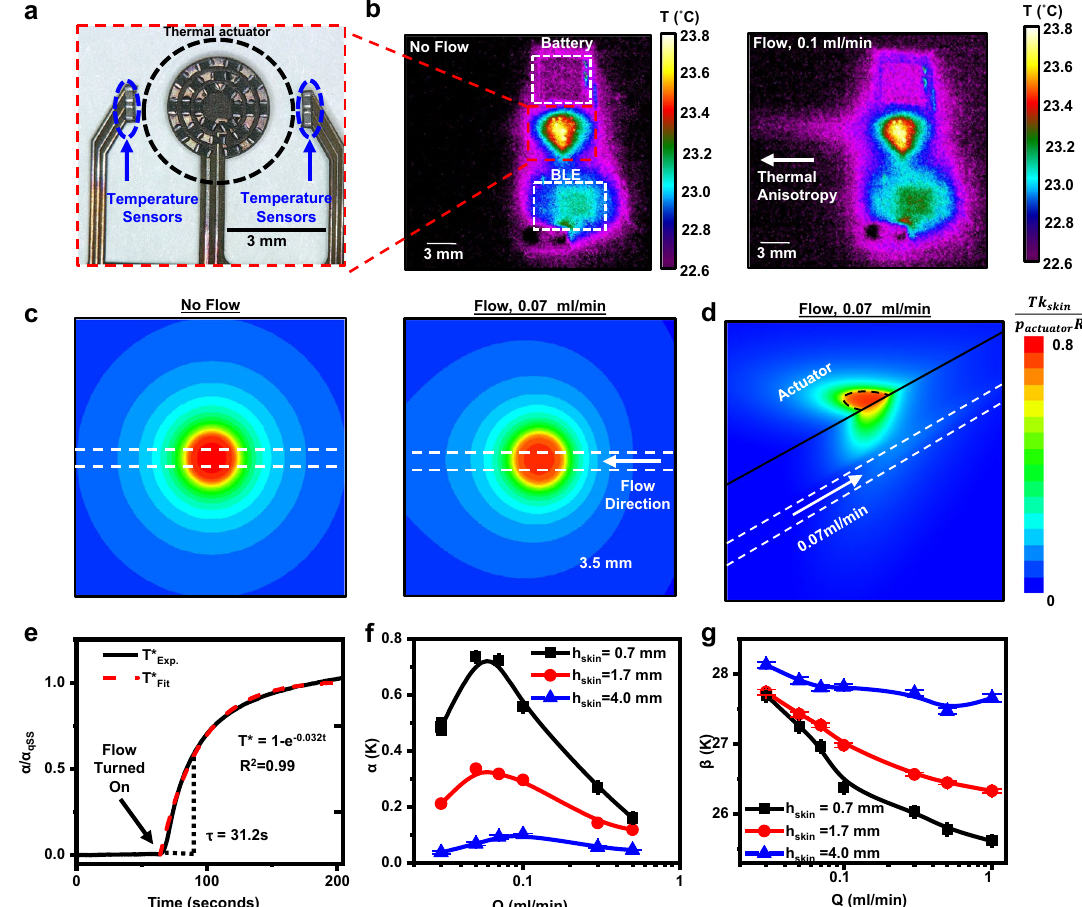
Fig. 2 Thermal and mechanical characterization of the fl ow sensor. a Optical micrograph of the circular thermal actuator and sensing elements on fPCB. b Infrared (IR) images of thermal actuation in the absence (left) and presence (right) of fl ow ( Q = 0.07 ml/min) in benchtop shunt assembly. c Temperature distributions generated by 3D fi nite element analysis (FEA)(top-view), illustrating the effects of no fl ow (left) and fl ow (right) for a representative case, with color scheme corresponding to a normalized change in temperature. d Cutaway view of images generated by 3D FEA illustrating heat transfer through near-surface skin layers for Q = 0.07 ml/min. e Plot of α / α qss = (T DS − T US )/ (T DS − T US ) qss as a function of time before and after a step-change in fl ow, from 0 ml/min to 0.3 ml/min, at t = 65 s, for the shunt phantom system with an equivalent skin thickness of 1.7 mm and fi tted with an exponential form to yield a time constant of 31 s to reach 63.7% of a quasi-steady-state (cid:1) (cid:3) (cid:4) 0 f Plot of α as function of different physiologically relevant fl ow rates (0.03 < Q < 0.5 ml/min) and skin thickness, h skin = 0.7 mm value ∂ α ð t Þ ∂ t (black), 1.7 mm (red) and 4.0 mm (blue), highlighting non-monotonic behavior and an in fl ection point at Q = 0.07 ml/min. g β = ( T DS + T US ) /2 computed for the same fl ow rates and skin thicknesses as in f . Error bars in f and g correspond to standard deviations over 100 s for a single